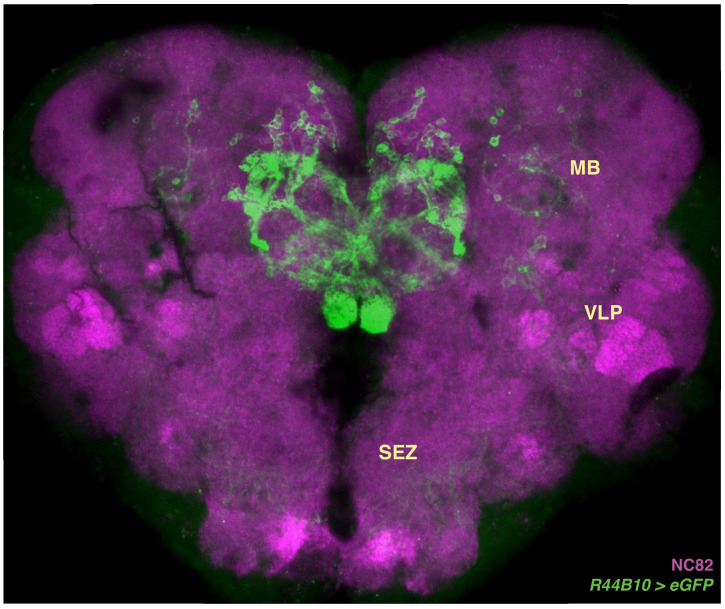
Full central brain anatomy of R44B10-GAL4.Little GFP expression can be seen outside of the CX in R44B10-GAL4. Weak off-target signal is present in the mushroom bodies (MB), ventrolateral protocerebrum (VLP), and sub-esophageal zone (SEZ). These regions are not labeled in the split-GAL4 lines we used. Neuropil in magenta.